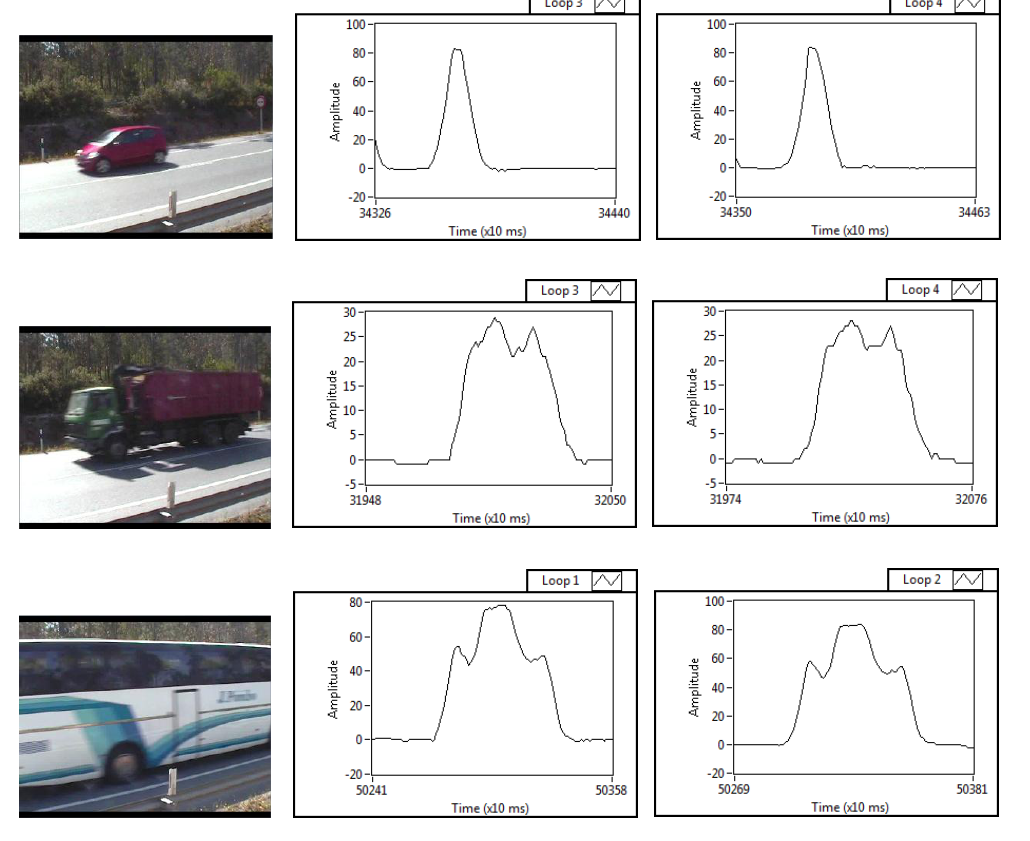
Figure 14. From left to right, the upper figures show the photo of a car and the respective signatures obtained with the Loops 3 and 4. The figures in the middle of the picture show a truck and its corresponding signatures captured also using the Loops 3 and 4. The lower figures display the photo of a bus and two signatures obtained with the first and the second loop,